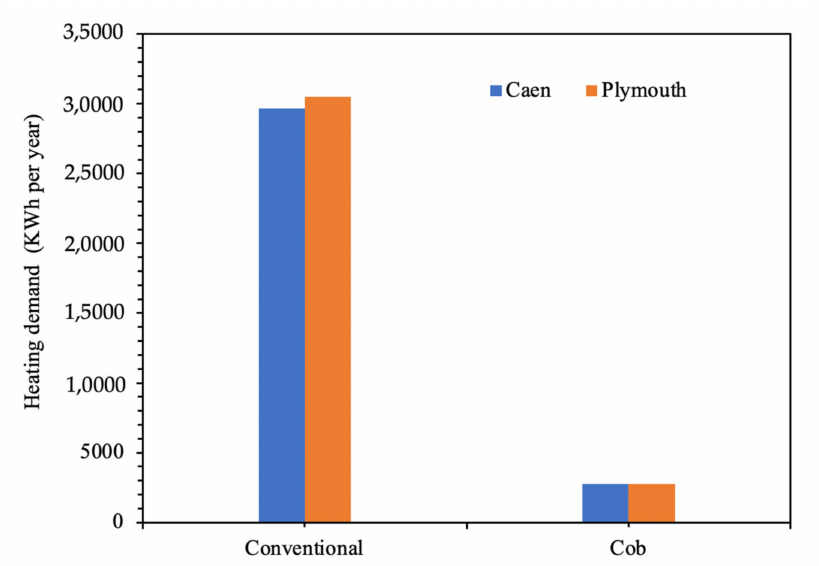
Figure 22. Mean outdoor temperature over ten years in Caen and